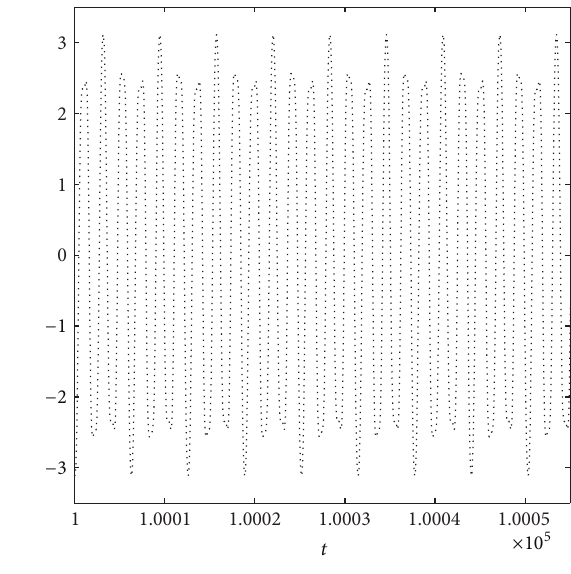
Figure 7: Time history curve (𝑡, ̇𝑦) .